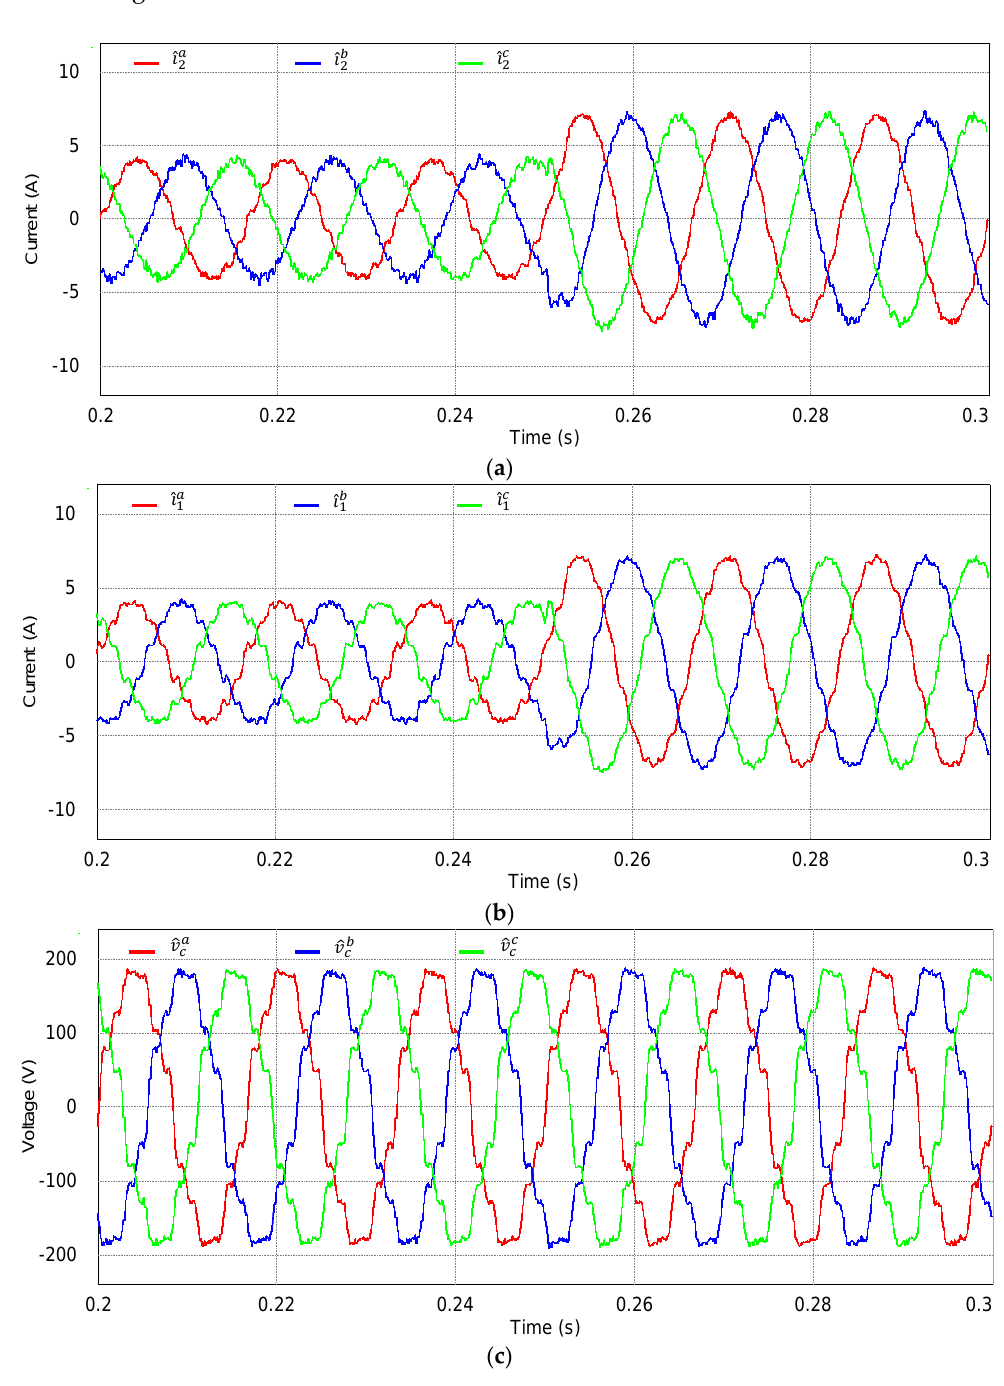
Figure 10. Simulation results for estimated three-phase variables with state observer under step change in q -axis current reference. ( a ) Estimated three-phase grid-side currents; ( b ) estimated three-phase inverter-side currents; ( c ) estimated three-phase capacitor voltages. To verify the quality of injected grid currents for the proposed integral-resonant controller under a distorted grid voltage, Figure 11 shows the FFT result for grid-side a -phase current with the harmonic limits specified by the grid interconnection regulation IEEE Std. 1547 [29]. As can be seen